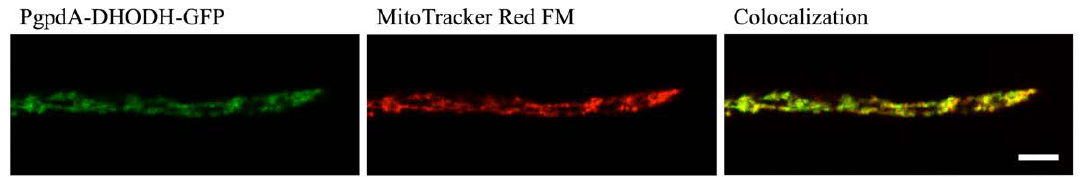
Figure 2. Colocalization of PgpdA-DHODH-GFP with the mitochondrion-selective dye MitoTracker Red FM indicates that A. fumigatus has a class 2 DHODH that is localized in the mitochondria. Scale bar = 5